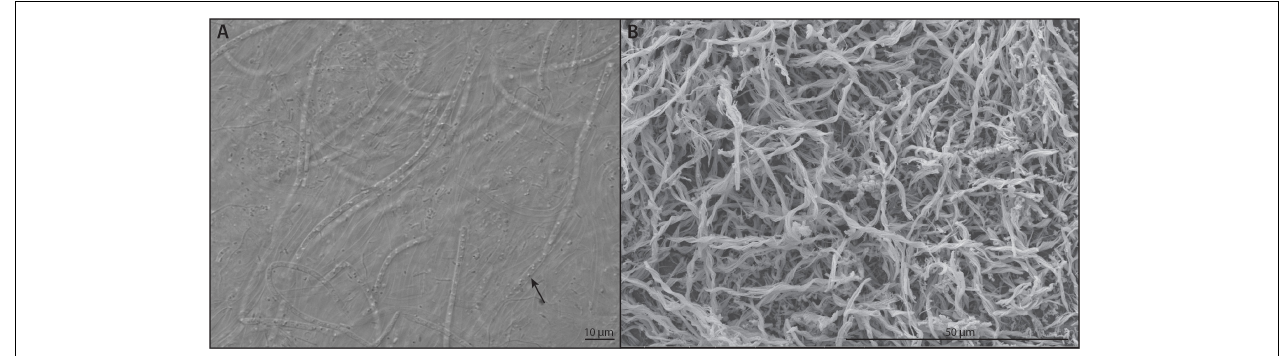
FIGURE 11 | Microscopic images indicating microbial metabolisms. (A) light microscopy image of a putative sulfide oxidizing filamentous bacterium with intracellular S 0 globules (arrow) taken from the outflow of D5 (B) SEM image of a twisted iron oxide stalk from the outflow of D3 produced by putative iron oxidizing bacteria.